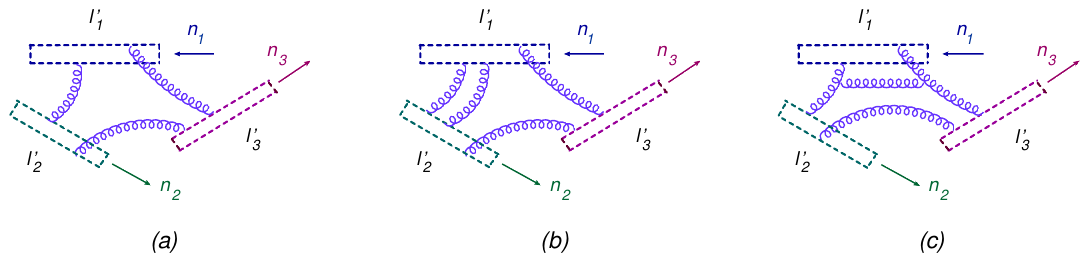
Figure 8 . Three Wilson frames in the leading order (\a") and at the one-loop level